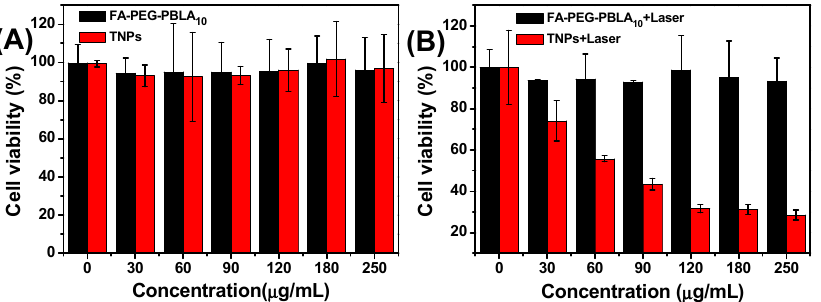
Figure 7. In vitro cytotoxicity test using FA-PEG-PBLA 10 and TNPs against HeLa cells ( A ) dark toxicity depending on the nanoparticles concentration and ( B ) phototoxicity depending on nanoparticles concentration.